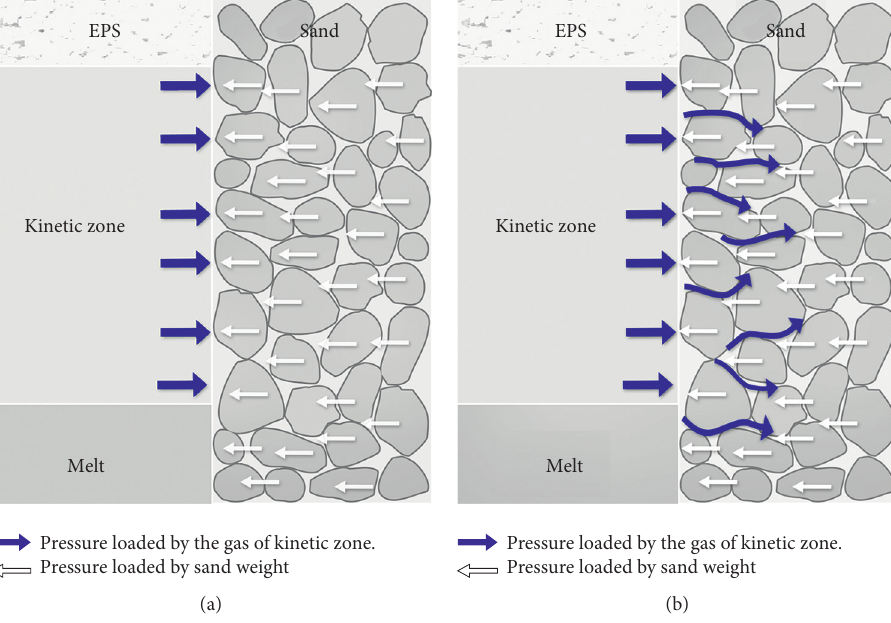
Figure 5: Schematic illustration showing the difference between the Shulyak model and the model suggested in this study. (a) Shulyak’s model, the gas of the kinetic zone applies the pressure only to the grains of sand on the surface of the kinetic zone, and (b) the model proposed in this study, the gas of the kinetic zone simultaneously pushes the sand on the surface and